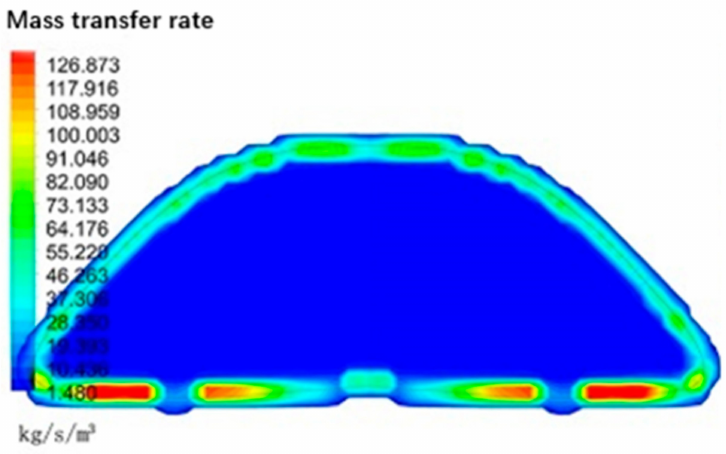
Figure 9. Mass transfer rate cloud diagram.